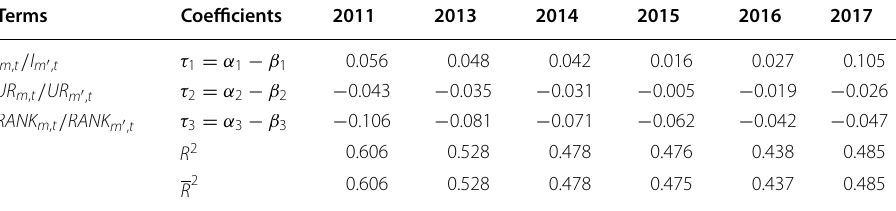
Table 7 Estimation of application preference via network asymmetry